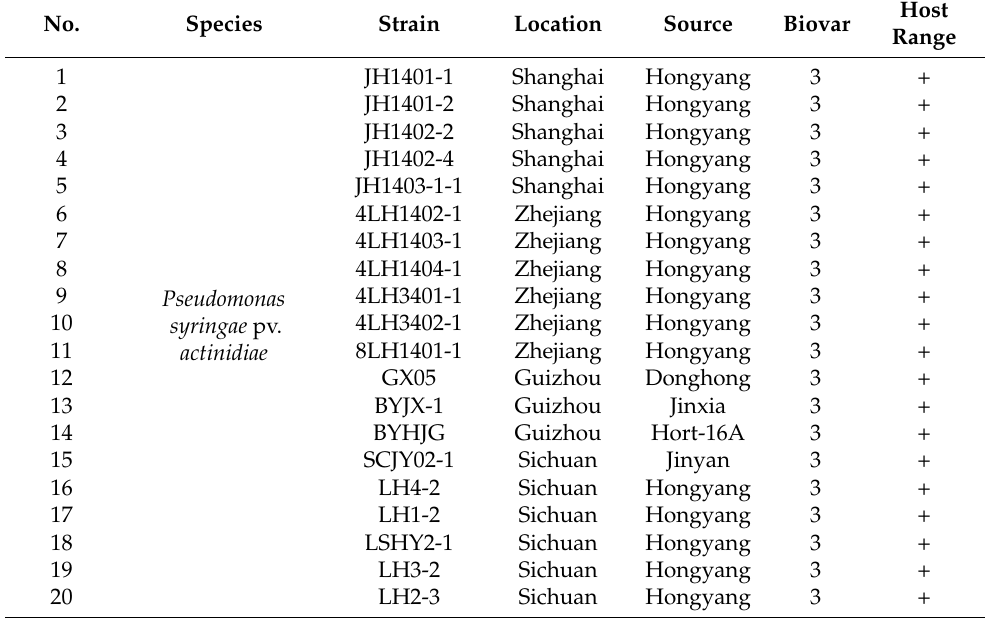
Table 1. Host range of phage